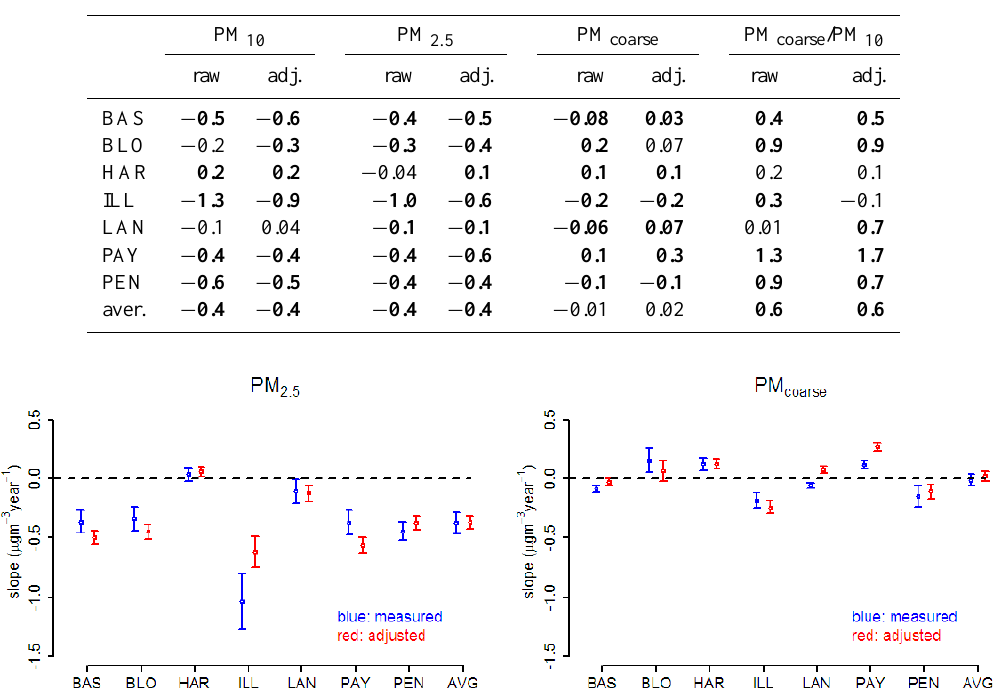
Table 5. Raw and meteorologically adjusted trends of PM 10 , PM 2 . 5 , PM coarse and the PM coarse /PM 10 ratio at all sites. The PM trends are given in µgm − 3 yr − 1 and the PM coarse /PM 10 ratio trends are given in %yr − 1 . Trends whose 95% confidence intervals do not overlap with zero are given in bold. A graphical depiction of the 95% confidence interval of the PM 2 . 5 and PM coarse trends is provided in Fig. 4. The last row is the average over all different stations.